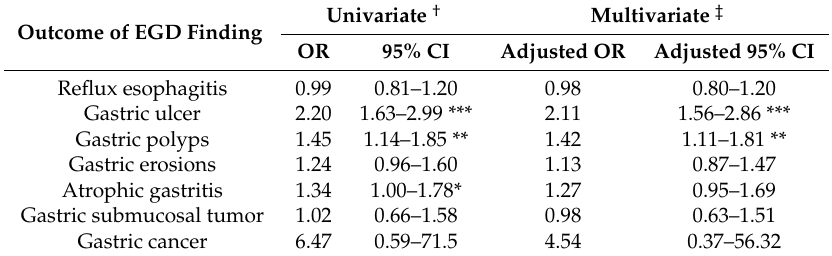
Table 5. Univariate and multivariate logistic regression of high serum CA72-4 level for di ff erent EGD